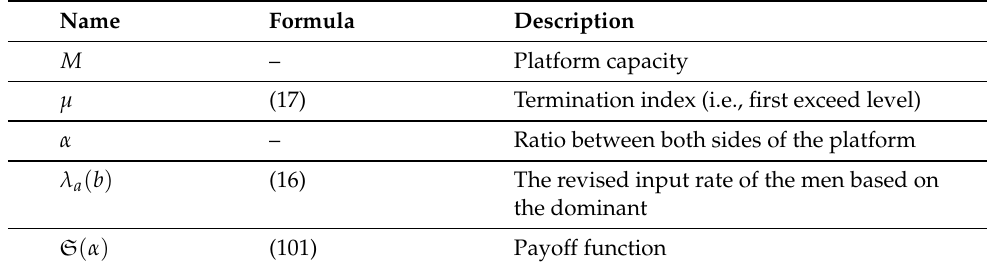
Table 1. The parameters for Two-sided platform